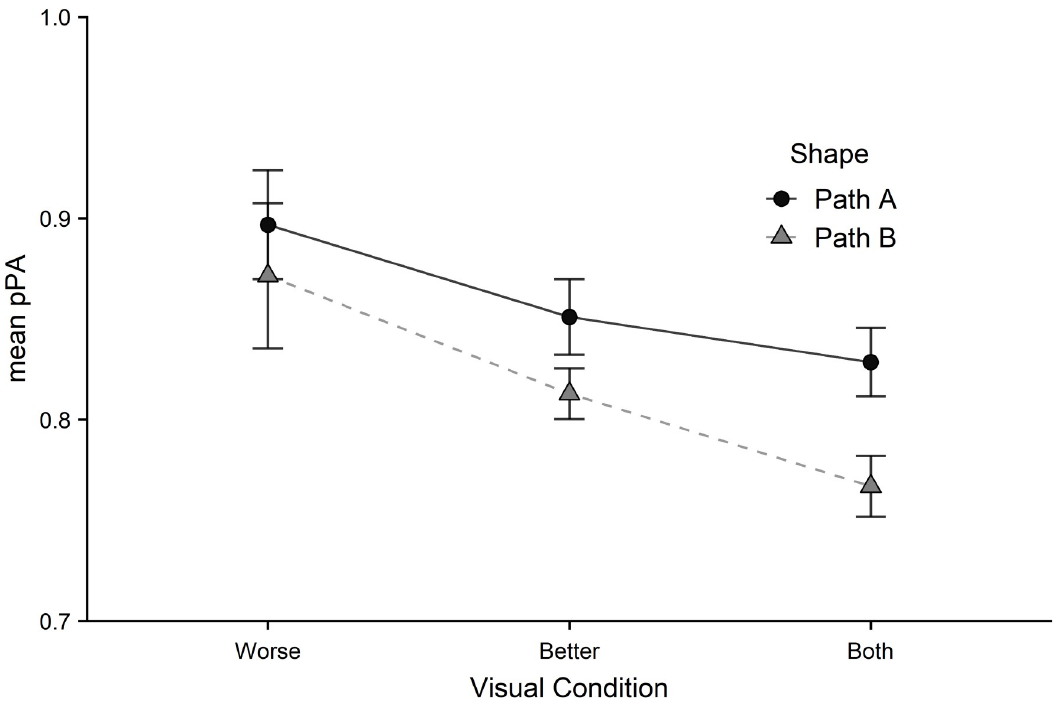
Fig 9. Steering performance was measured using mean penalised path accuracy (pPA) for both paths (circles = path A, triangles = path B) across all visual conditions (worse eye, better eye, both eyes). Error bars represent the standard error of the